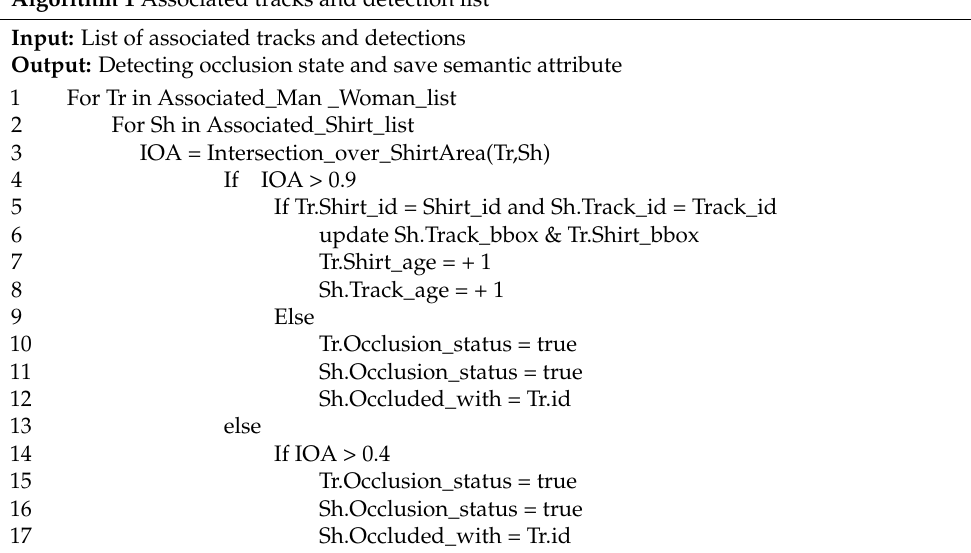
Algorithm 1 Associated tracks and detection Algorithm 1. Associated tracks and detection list.